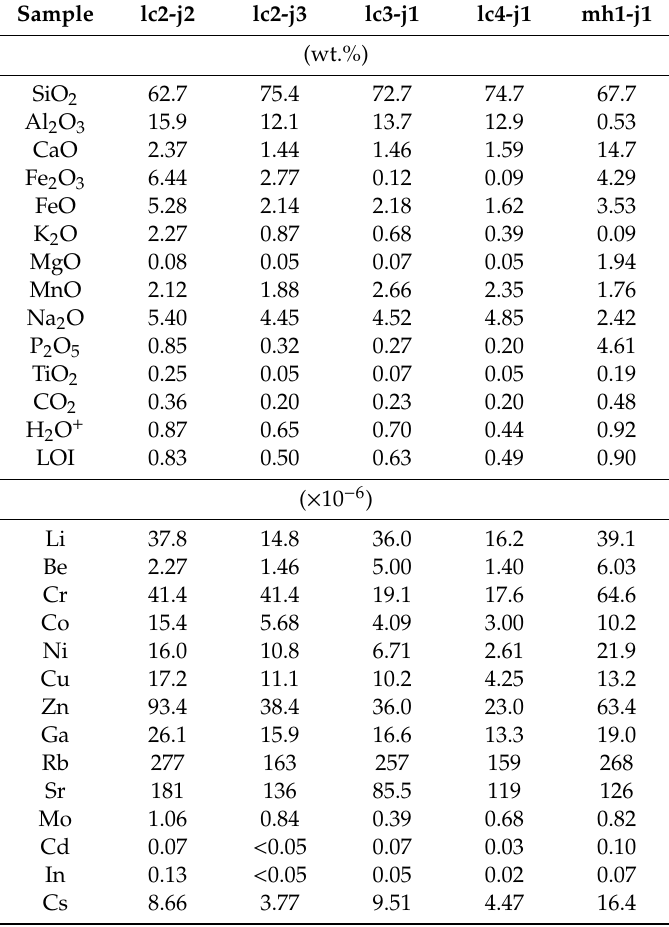
Table 2. Major (wt.%), trace elements ( × 10 − 6 ), and rare earth elements ( × 10 − 6 ) of QN and MH